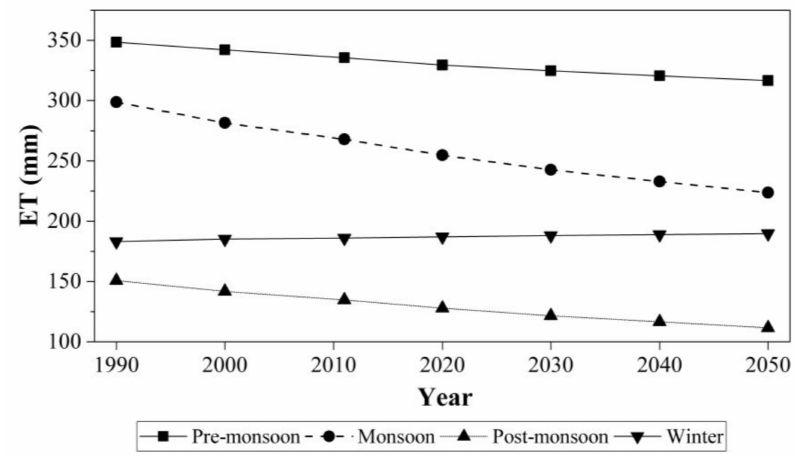
Figure 10. Land use change impact on